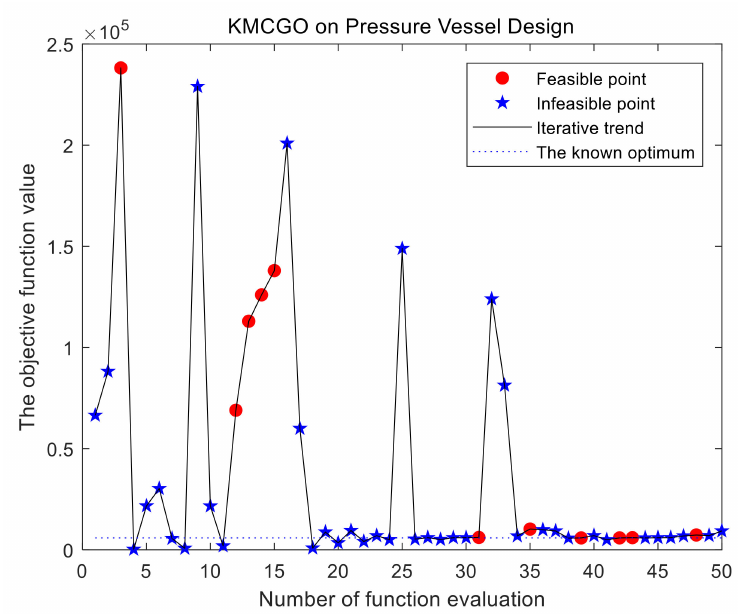
Figure 7. Iteration result of the PVD